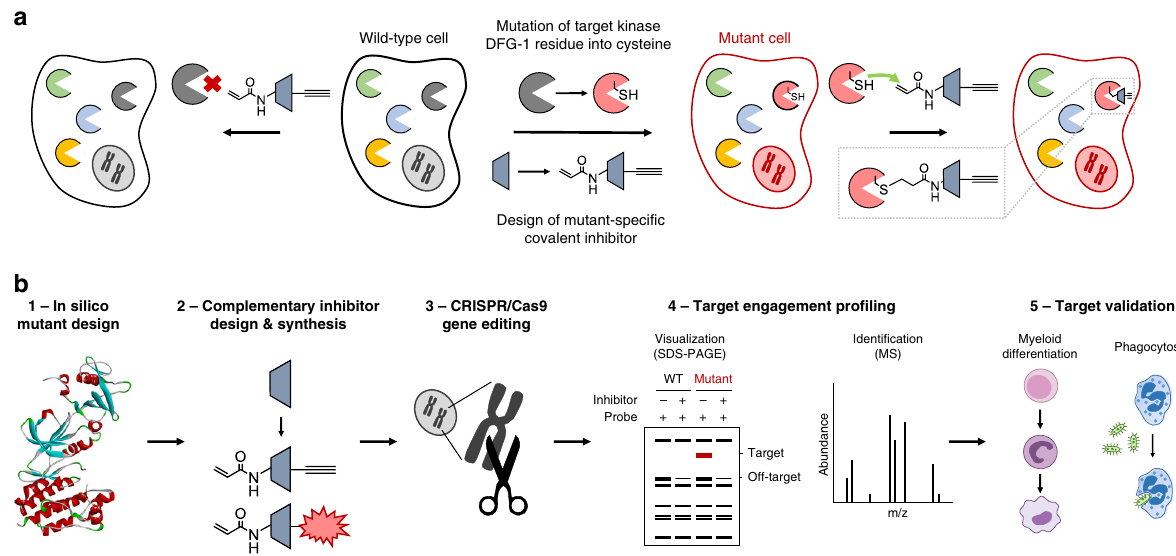
Fig. 1 Chemical genetics strategy to visualize kinase activity and target engagement. a General strategy involving mutagenesis of a kinase DFG-1 residue into a nucleophilic cysteine accompanied by mutant-speci fi c covalent inhibitor design. A non-selective, reversible inhibitor is modi fi ed with an acrylamide electrophile to covalently react to the introduced cysteine, along with an alkyne ligation handle for (bioorthogonal) conjugation to reporter tags using click chemistry. The mutation is introduced in a relevant cell line using CRISPR/Cas9 gene editing in order to study the kinase in an endogenous expression system. b Schematic work fl ow for application of mutant-speci fi c, complementary probes in target engagement and target validation